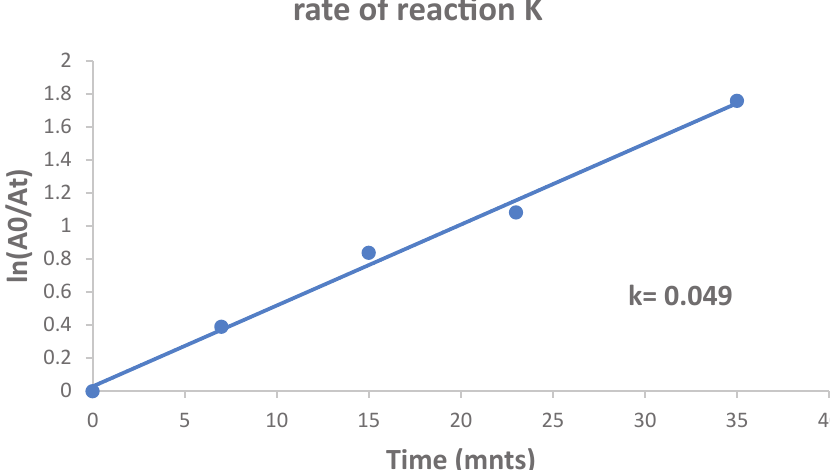
Figure 13: Rate constant K calculated for the reduction of para-nitrophenol.